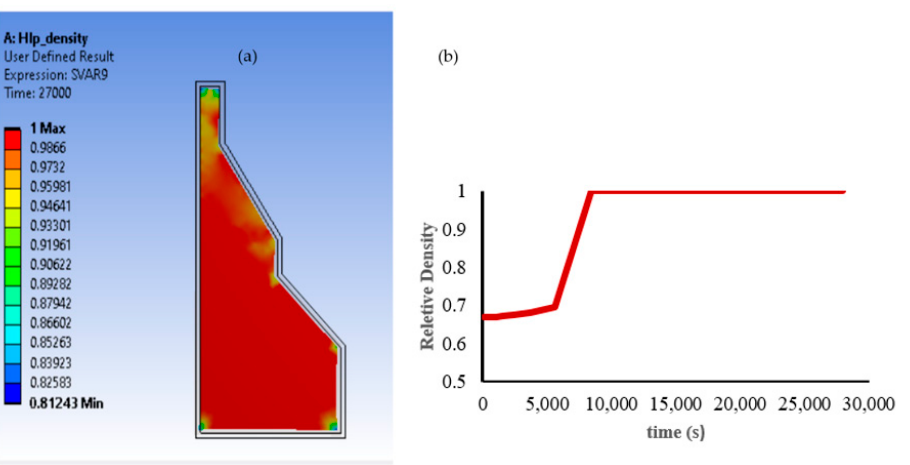
Figure 8. Contour plot of location-dependent relative density ( a ) for the part at the end of the HIP cycle and ( b ) during the HIP cycle.